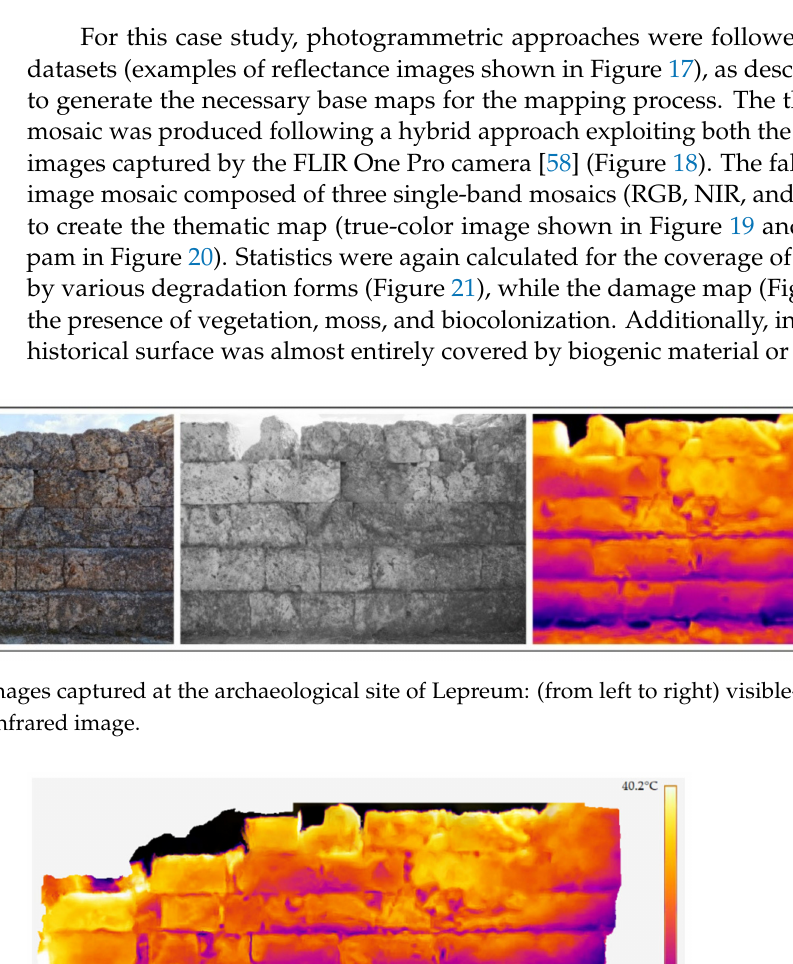
Figure 16. Ancient walls at the archaeological site of Lepreum.